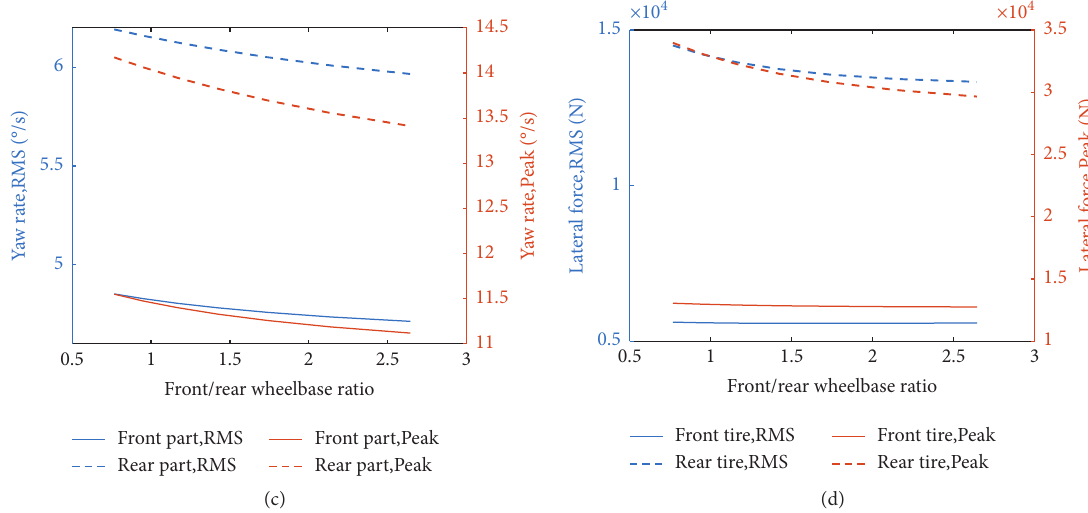
Figure 14: Vehicle performance of the wheelbase ratio variation. (a) RMS and peak value of tire sideslip angle. (b) RMS and peak value of vehicle sideslip angle. (c) RMS and peak vehicle yaw rate. (d) RMS and peak value of lateral